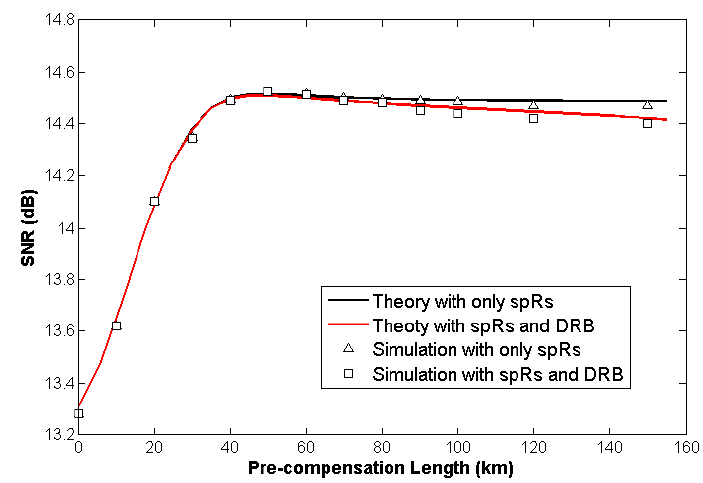
Figure 8. SNR vs. the pre-compensation length, with and without DRB. Figure 8. SNR vs. The pre-compensation length, with and without